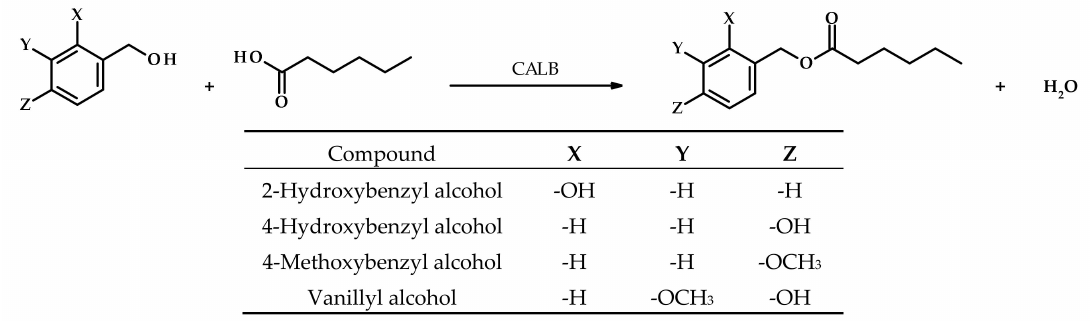
Figure 1. Lipase-catalyzed synthesis of hexanoic acid